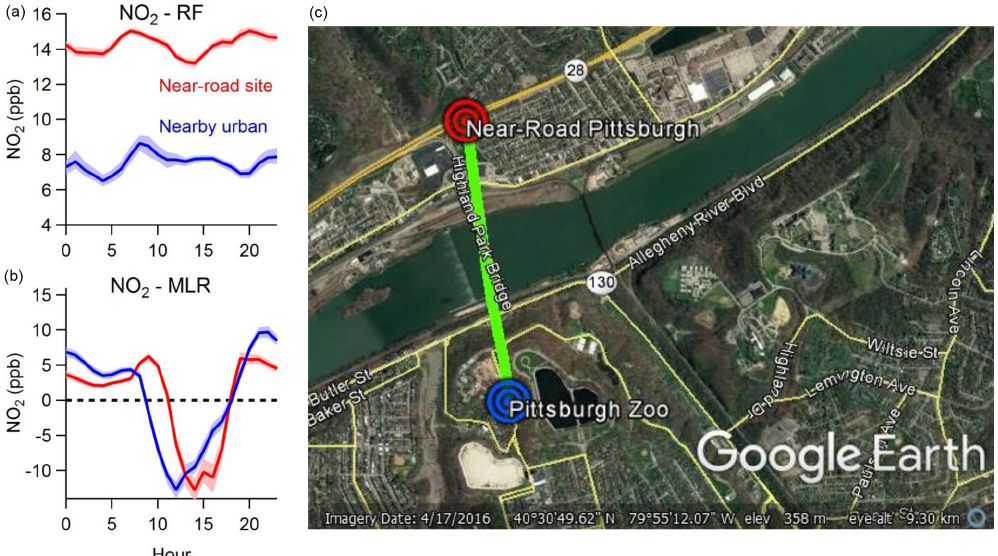
Figure 15. Diurnal NO 2 patterns at two nearby sites (one urban, one near-road) measured by RAMP monitors calibrated using RF models (a) or MLR models (b) . (c) Satellite view of the two sites, which were ∼ 1.5km apart. The urban site was at the Pittsburgh Zoo, and the near-road site was within 15m of Highway